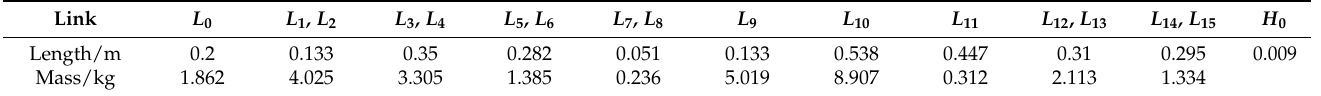
Table 1. Physical parameters of the humanoid robot.